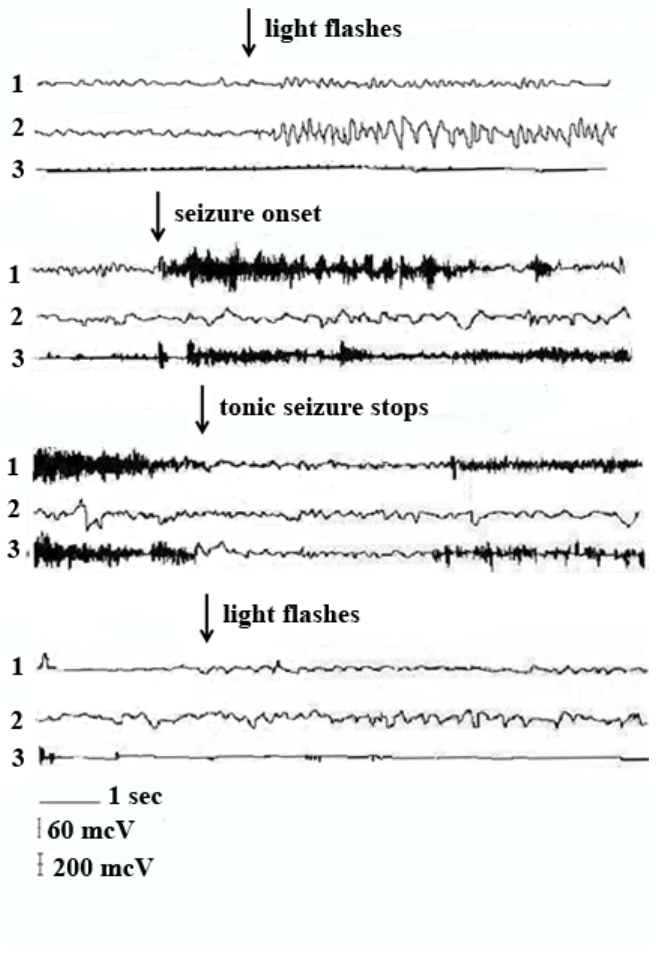
Figure 2. The electroencephalogram (EEG) and electromyogram (EMG) patterns, recorded from chronic electrodes in KM rat during experiment before seizure onset (upper part), during seizure (two middle parts) and after the seizure (the lower part of the figure). Electrodes positions: 1, brain stem; 2, visual cortex; 3, electromyogram (EMG). Calibration: horizontal bar-time scale, vertical bars, 60 mcV for EEG; 200 mcV for EMG (see also [18]).